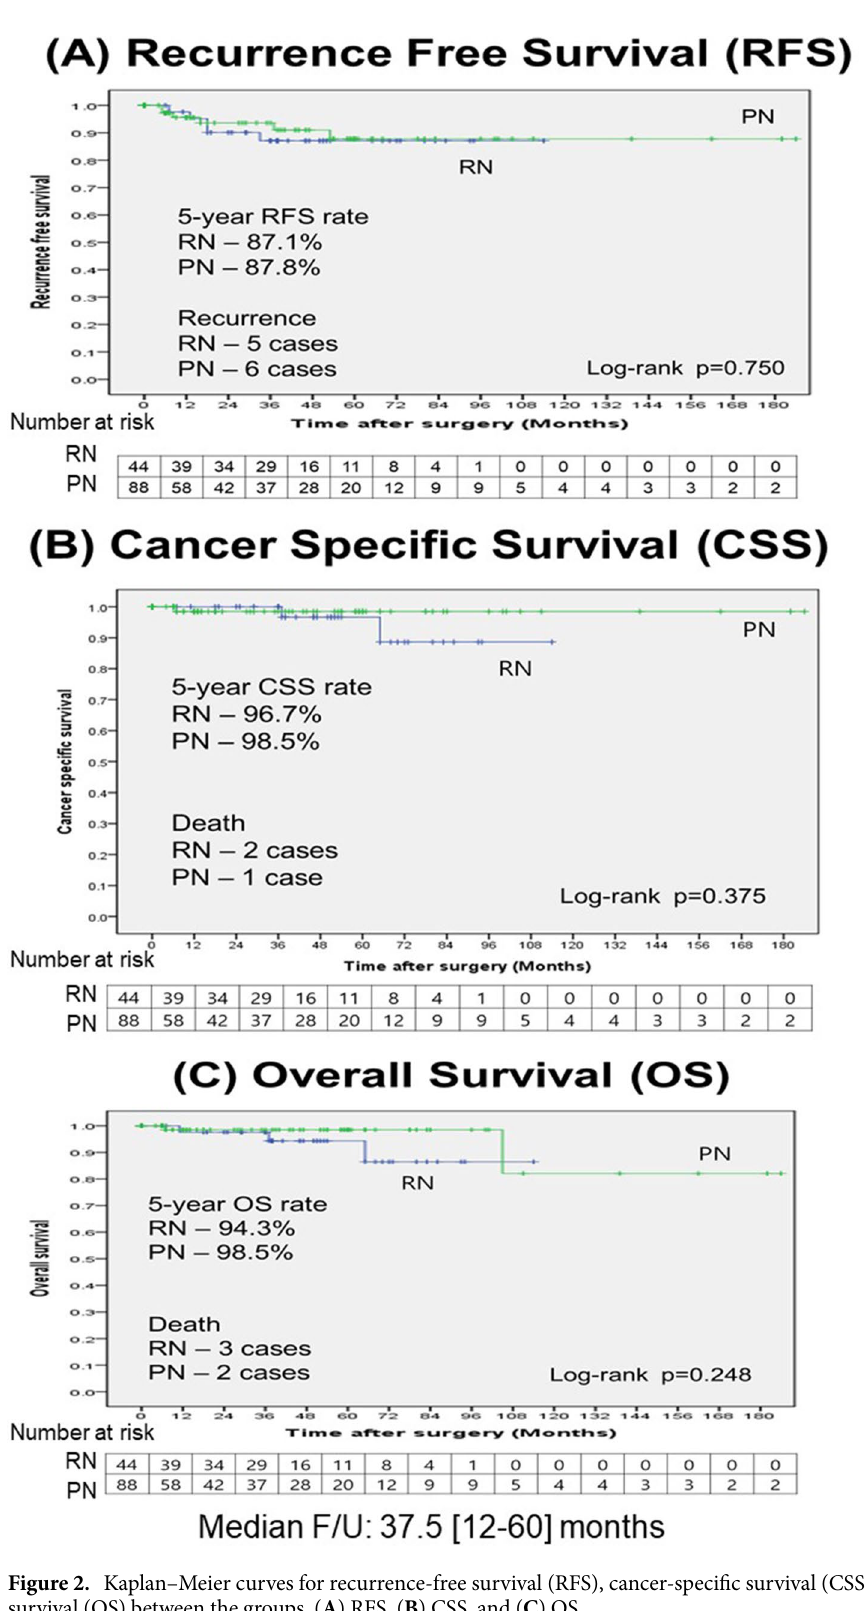
Figure 2. Kaplan–Meier curves for recurrence-free survival (RFS), cancer-specific survival (CSS), and overall survival (OS) between the groups. ( A ) RFS, ( B ) CSS, and ( C )